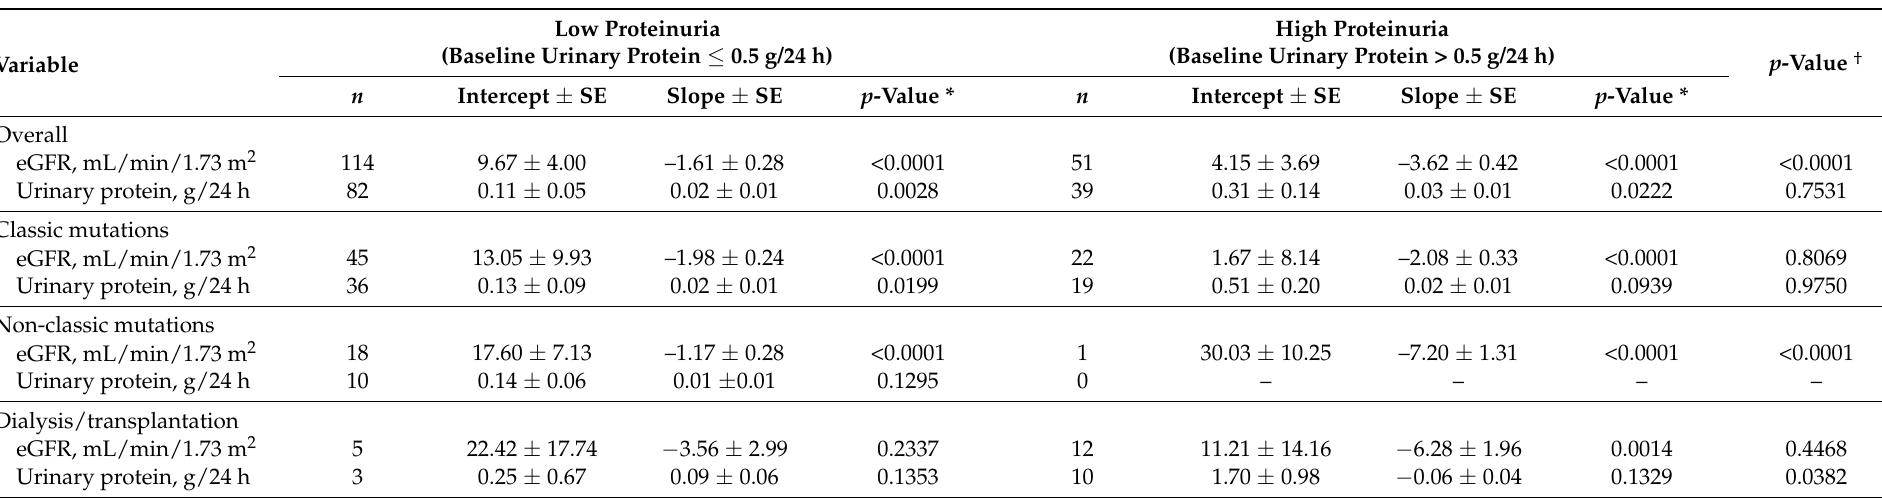
Table 4. Mixed effect linear regression analysis of clinical endpoints by level of proteinuria at